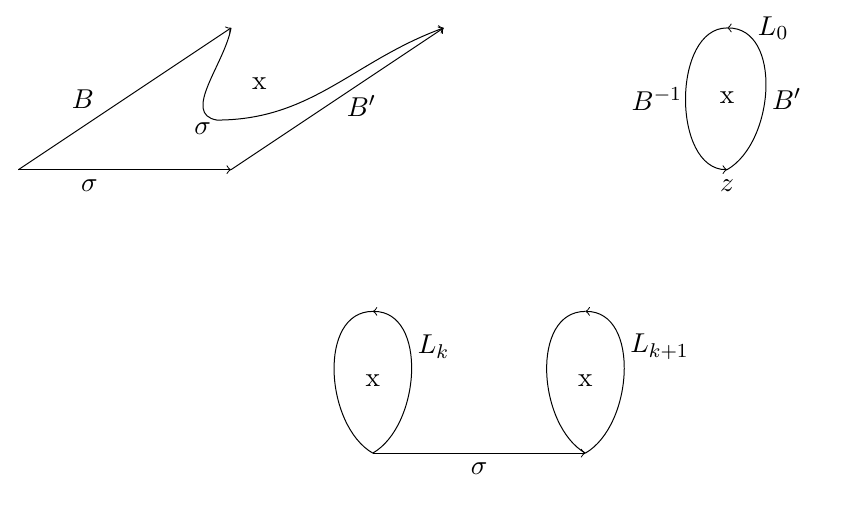
Figure 3 . Algebra of